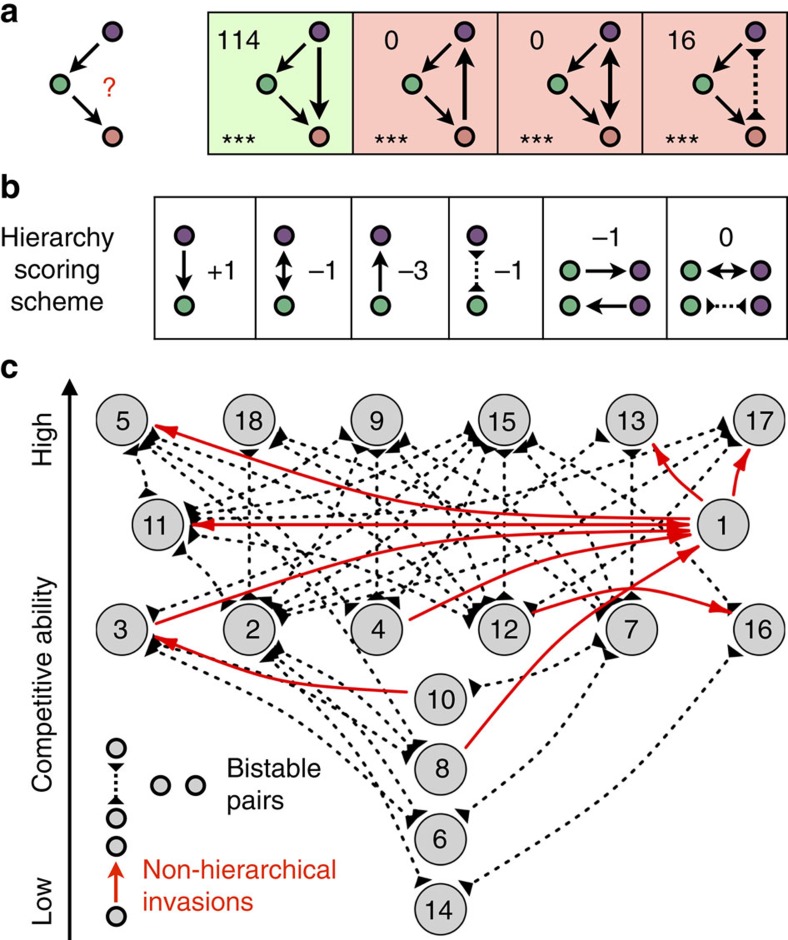
The invasion network is partly hierarchical with multiple strains in the top level exhibiting bistable relationships with each other.(a) Enrichment (green) or depletion (pink) of different triplet motifs relative to randomized networks preserving the number of each pairwise motif (Supplementary Fig. 3). Number of occurrences for each motif are given in the upper-left corner. Transitive invasions (leftmost motif) were highly enriched (***,P<1e−6), whereas the three intransitive motifs were highly depleted (***,P<1e−6). (b) The scoring scheme used in assigning hierarchy levels to strains rewards invasions pointing down the hierarchy and penalizes invasions directed against the hierarchy. (c) The invasion network overlaid on the hierarchy assignments that maximize the score in b. Strains were placed into seven hierarchy levels with six strains at the top level exhibiting bistable relationships with each other. Invasions going down the hierarchy are not shown, while others are shown in red. Bistability is denoted by a missing link between strains at the same level or by a dashed line for strains at different levels.